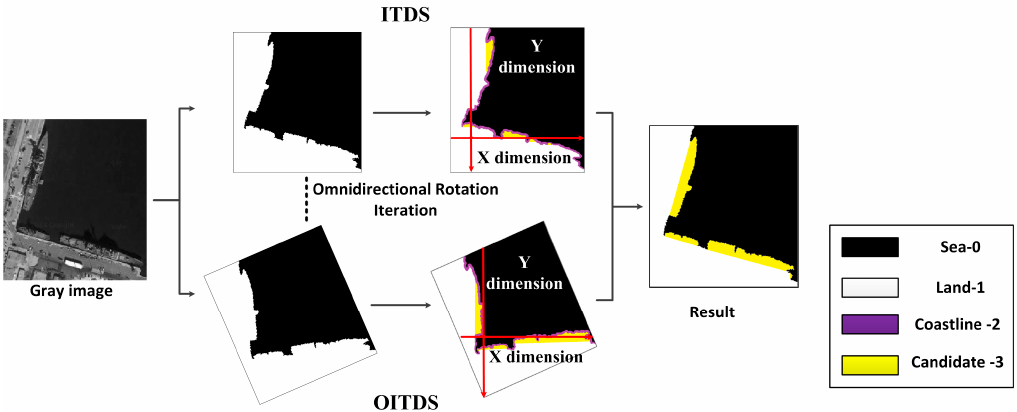
Figure 2. Omnidirectional intersected two-dimension scanning (OITDS)